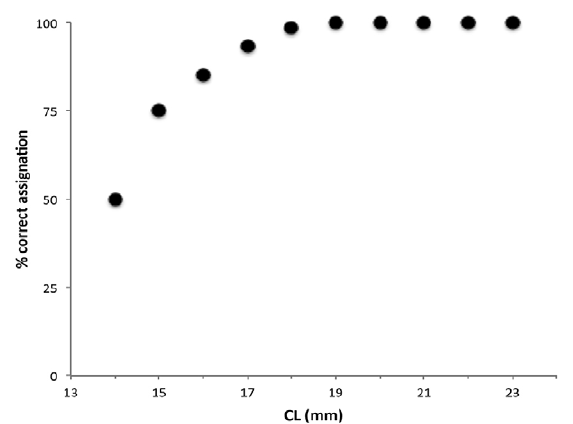
Fig. 5. – Percentage of correct gender assignation by size class in Pasiphaea sivado based on pleopod morphology observation with naked eye (N= 542).